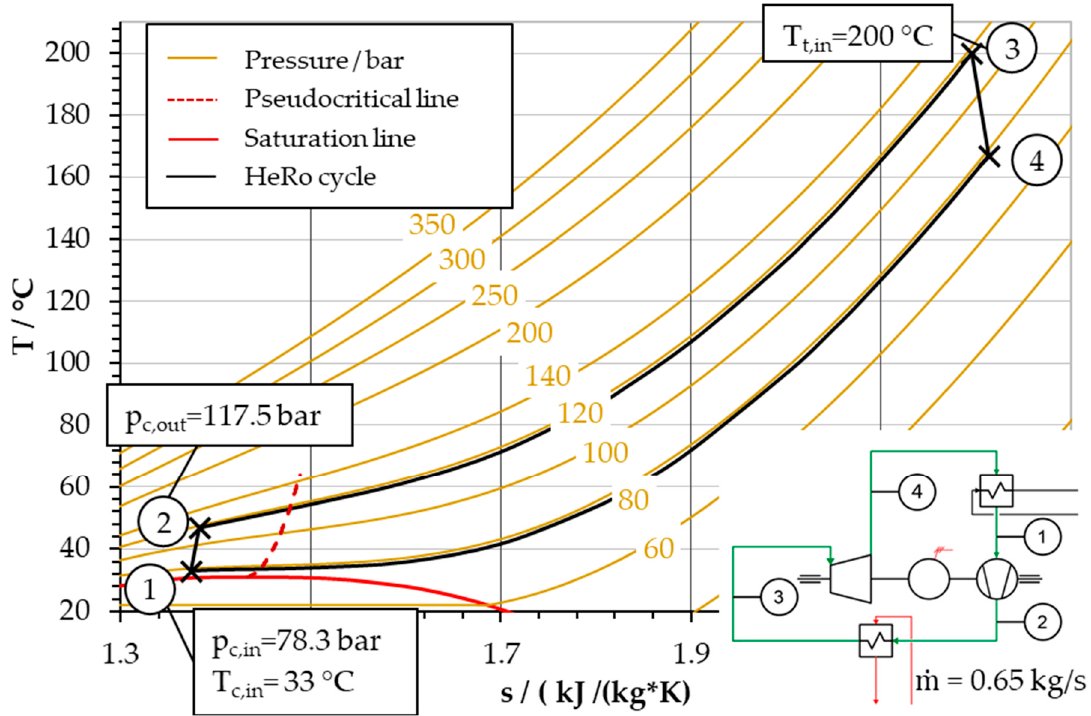
Figure 1. T–s diagram of the sCO2-HeRo cycle including a simplified sketch.